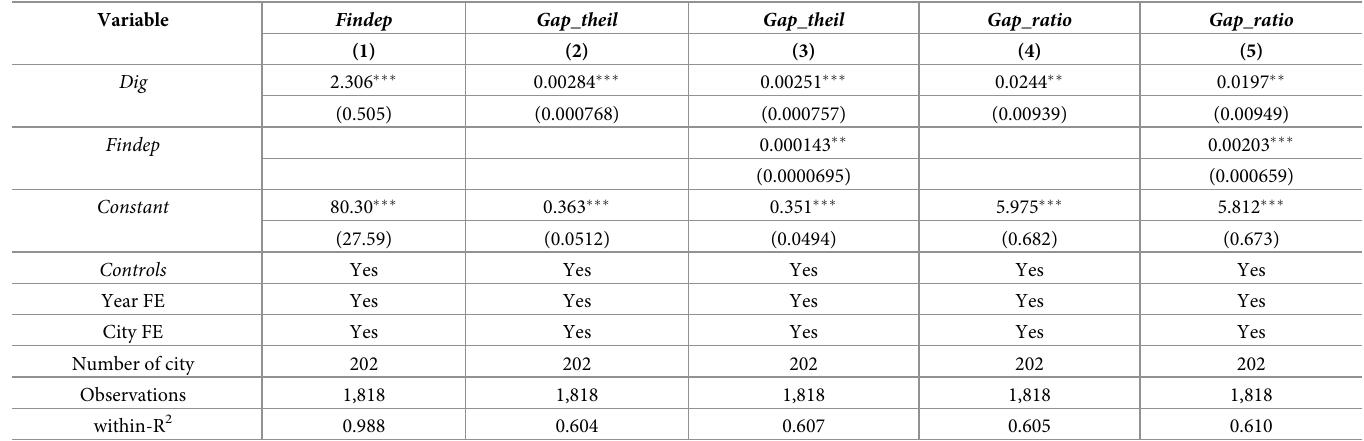
Table 4. Mechanism test: Mediating variable is Findep .